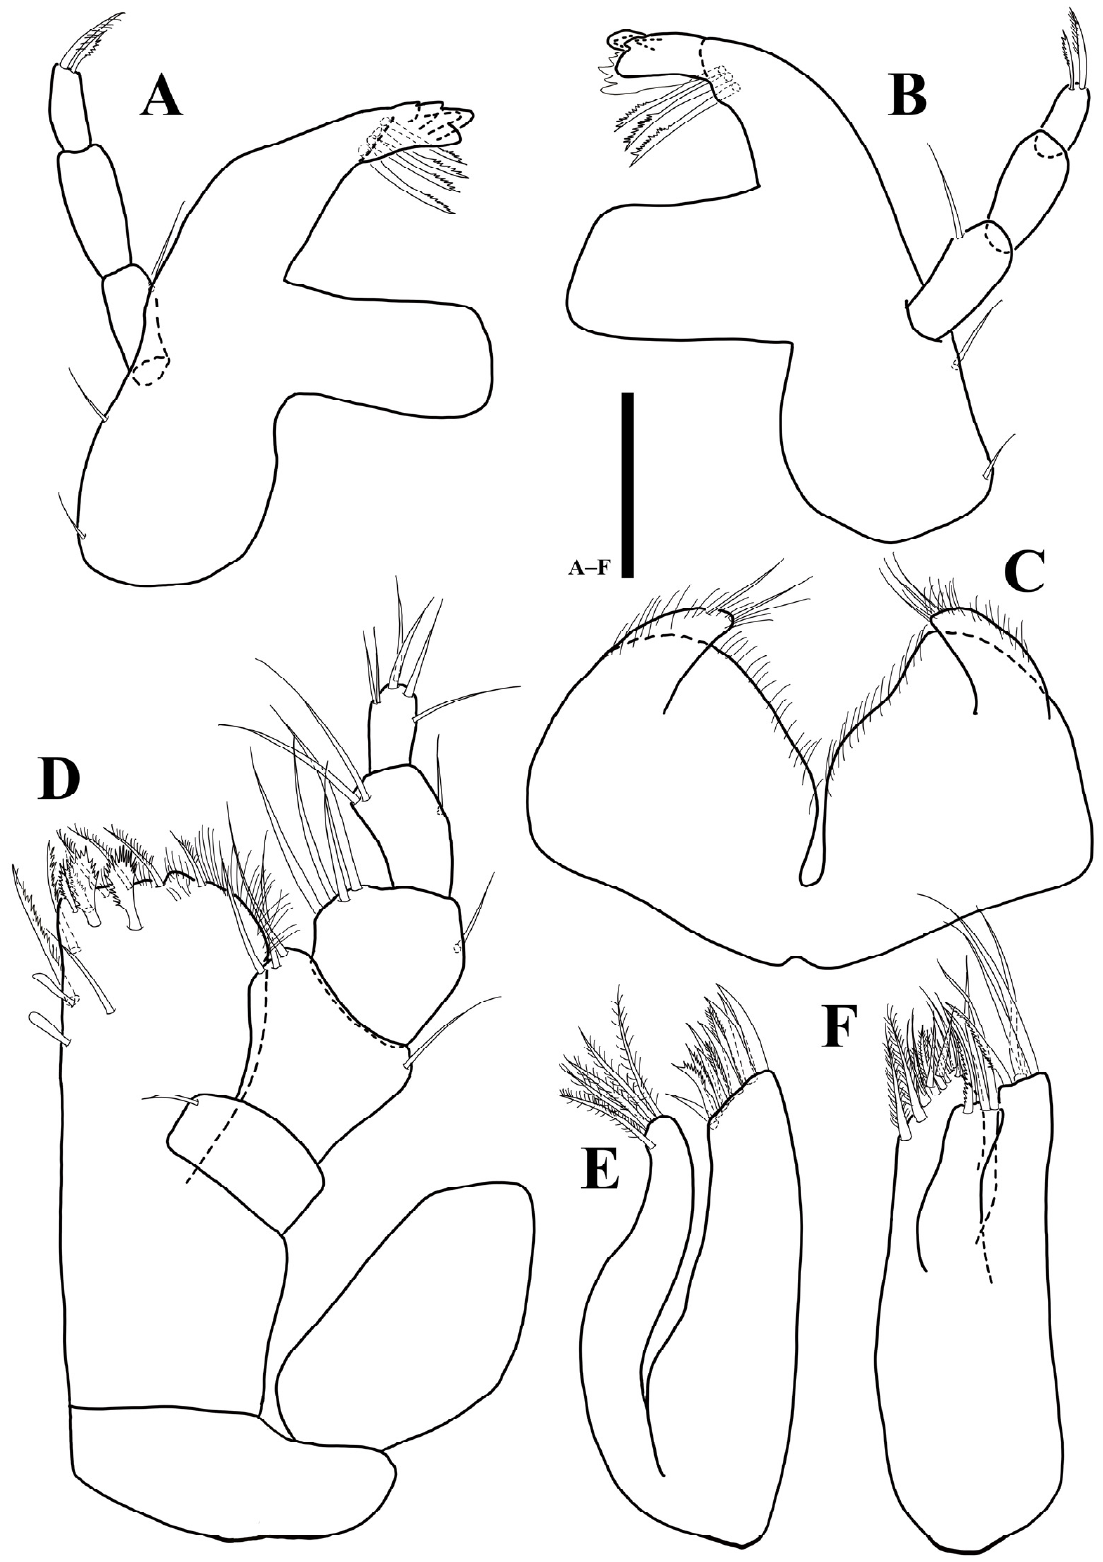
Figure 10. Uromunna jejuensis sp. n. holotype male: ( A ) right mandible; ( B ) left mandible; ( C ) labium; ( D ) maxilliped; ( E ) maxillula; ( F ) maxilla. Scale bars = 50 μ m.